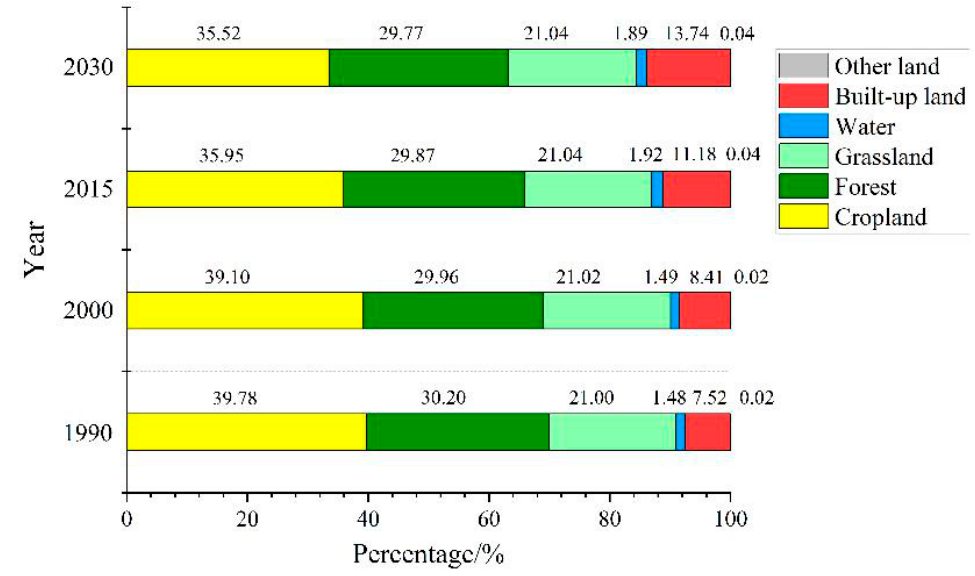
Figure 6. Percentage of the various land use types in 1990, 2000, 2015, and 2030.